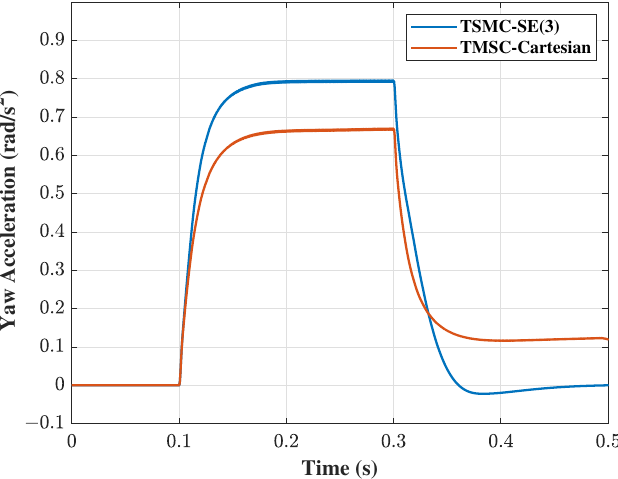
Figure 11. The step acceleration response comparison in the yaw